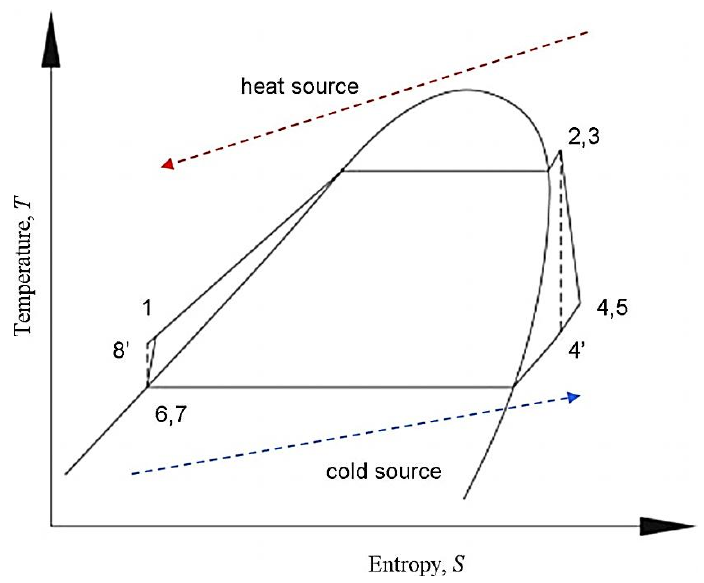
Figure 1. Basic T – s chart of an organic Rankine cycle (ORC).